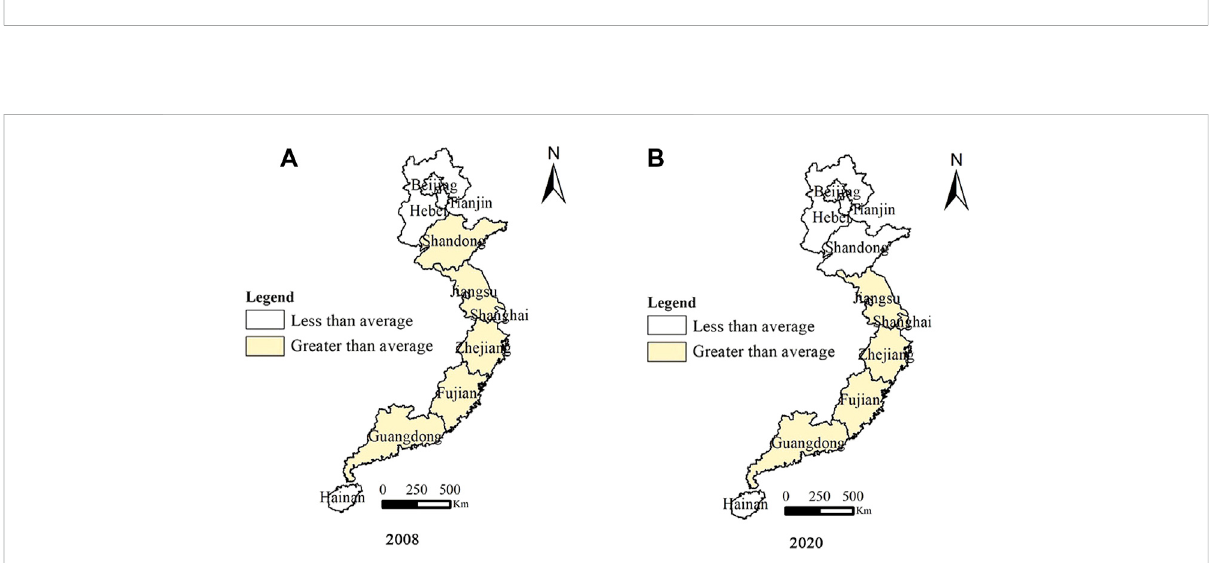
FIGURE 5 Spatial differentiation of industrial land employment dimension (2008 and